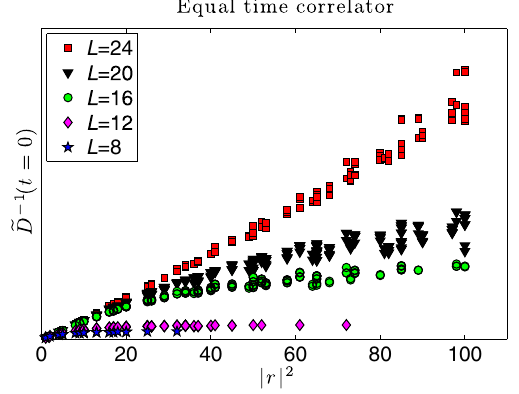
FIG. 13. The inverse of the equal time nematic correlator at h ¼ h and T ¼ 0 . 1 , plotted versus the square of the spatial c separation r for various system sizes. The narrow spread in the data (which have not been chosen to lie along any high- symmetry direction) indicates an emergent isotropy of the correlations in this regime. The apparent 1 = j r j 2 behavior in the thermodynamic limit is what one would get by Fourier trans- form of A from Eq.